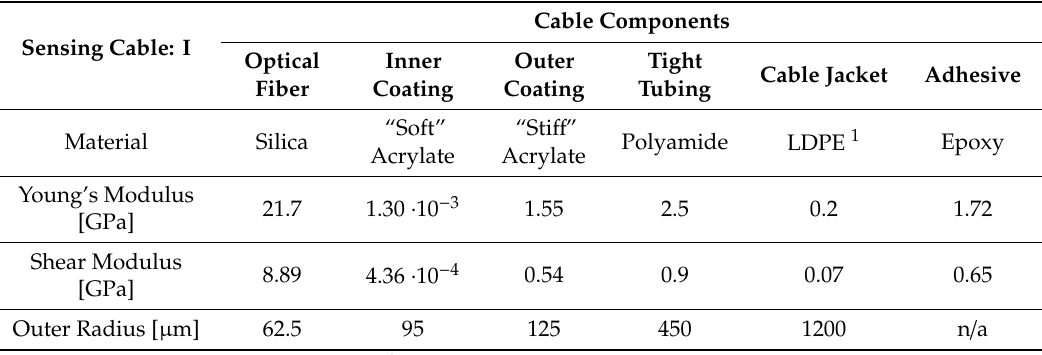
Table 1. Material properties and geometrical dimensions of the first sensing cable.